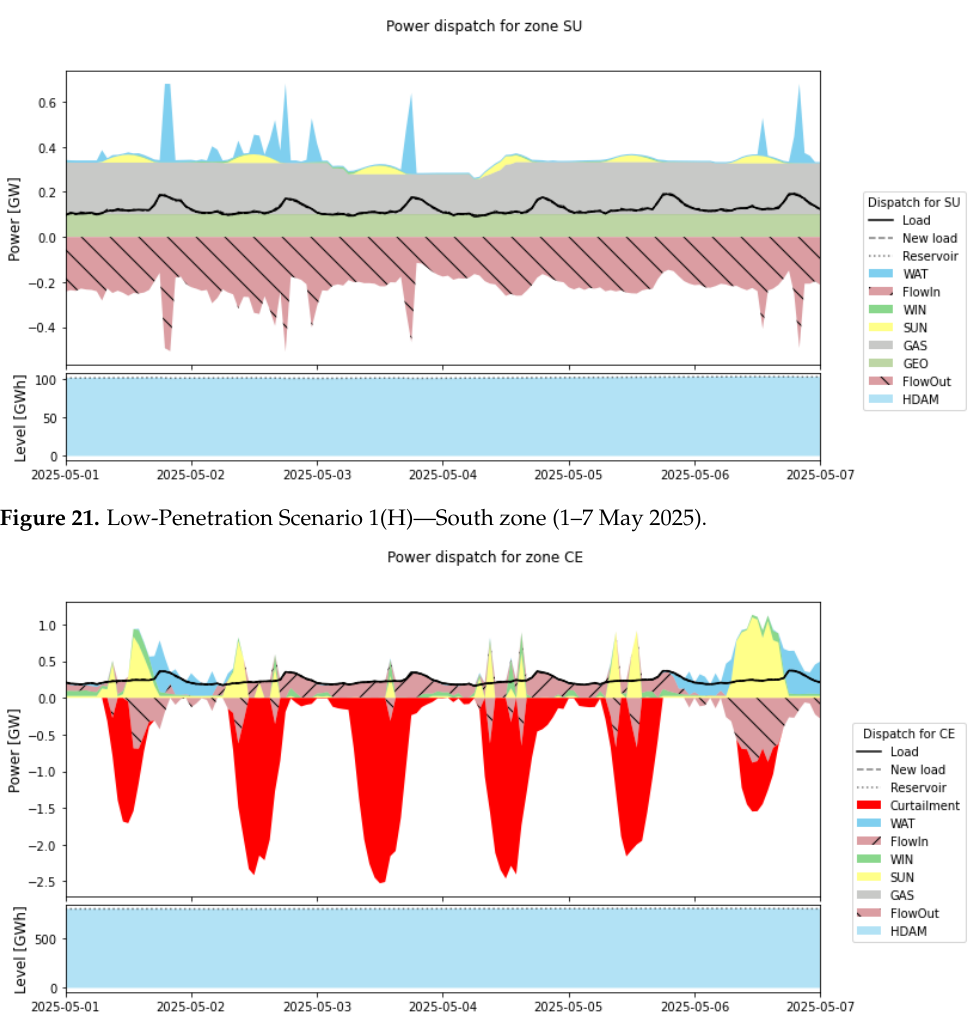
Figure 22. Very-High-Penetration Scenario 10(H)—Central zone (1–7 May 2025).